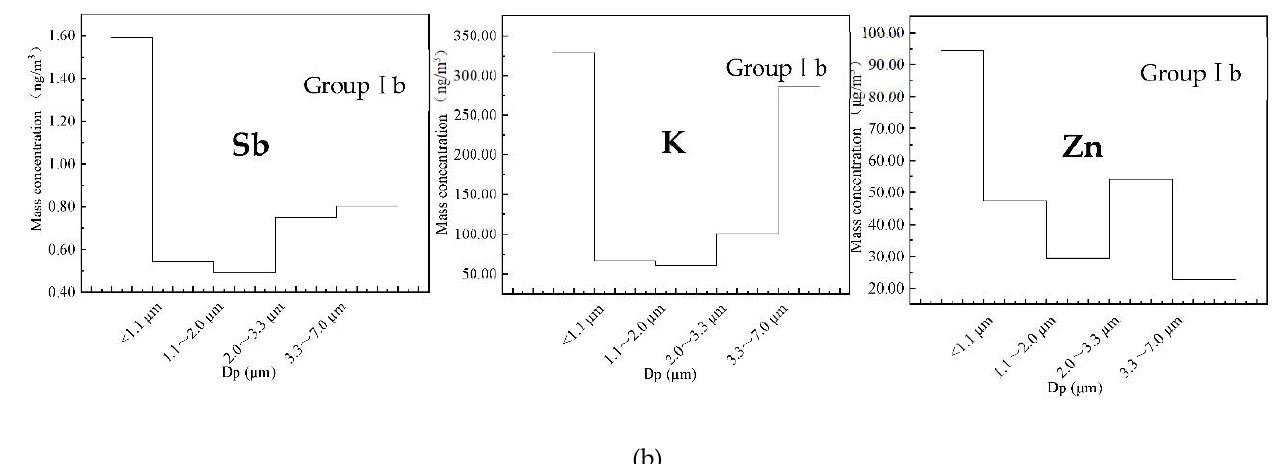
Figure 5. Potentially toxic metals with particle size - bimodal distribution. ( a ) Group I a is the mass concentration mainly concentrated in PM >7 . 0 ; ( b ) Group I b is the mass concentration mainly concentrated in PM 1 . 1 .